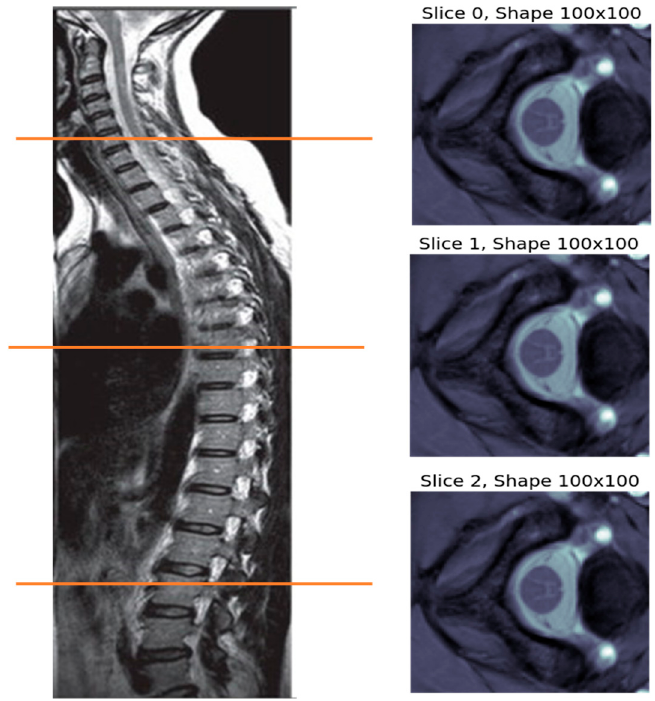
Figure 1. MRI volume for subject 1 of site 1, which is made up of three MRI slices captured at certain locations in the subject’s spine, as indicated by the colored horizontal lines.